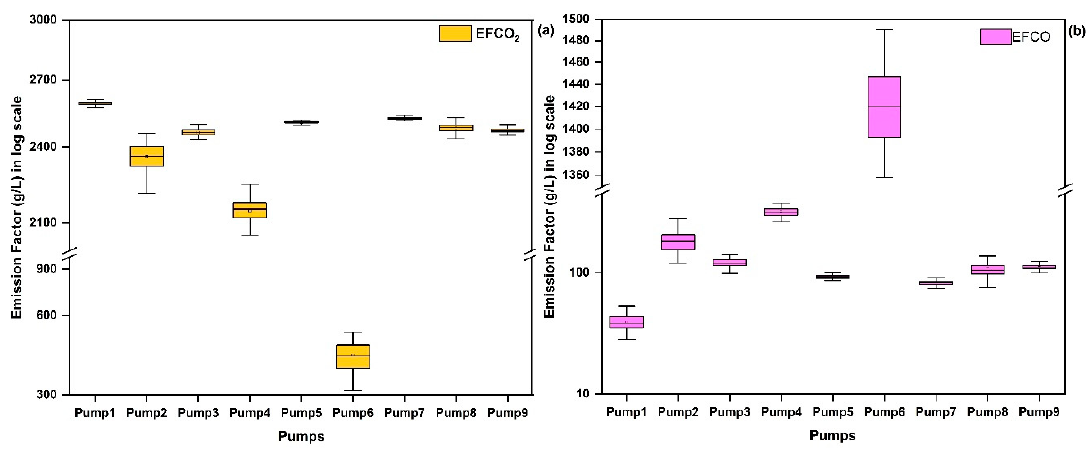
Figure 5. Box plot showing ( a ) EFCO 2 (g/L) and ( b ) EFCO (g/L) in log scale for all measured pumps. The lower and upper edge of each box represent the 25th and 75th percentiles, respectively; and the top and bottom of the whisker represent the 90th and 10th percentiles, respectively. The square box mark within each box represents the average EF and the horizontal mid-line in each box represents the median. EF, emission factors; EFCO 2 , emission factors carbon dioxide; EFCO, emission factors carbon monoxide. Table 2. Summary of emission factors for all measured pumps.